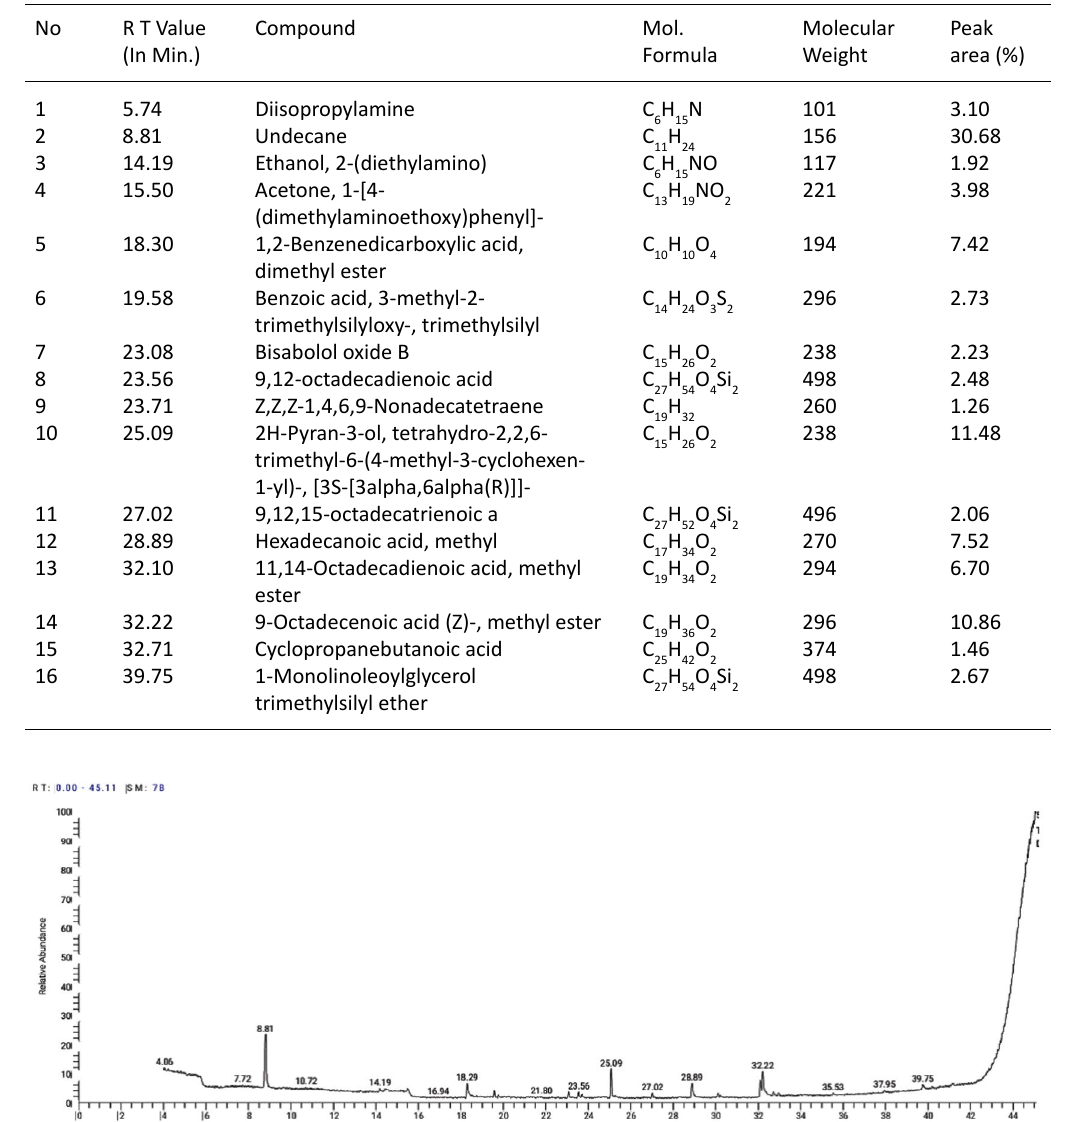
Fig. 11. GC-MS chromatogram and structure formulas of compounds of the bioactive compounds extracted from Streptomyces mutabilis M3 MT483919 [3alpha,-6alpha (R)]]and 9-Octadecenoic acid (Z)- methyl ester with Peak area percentage 30.68, 11.48 and 10.86 %,